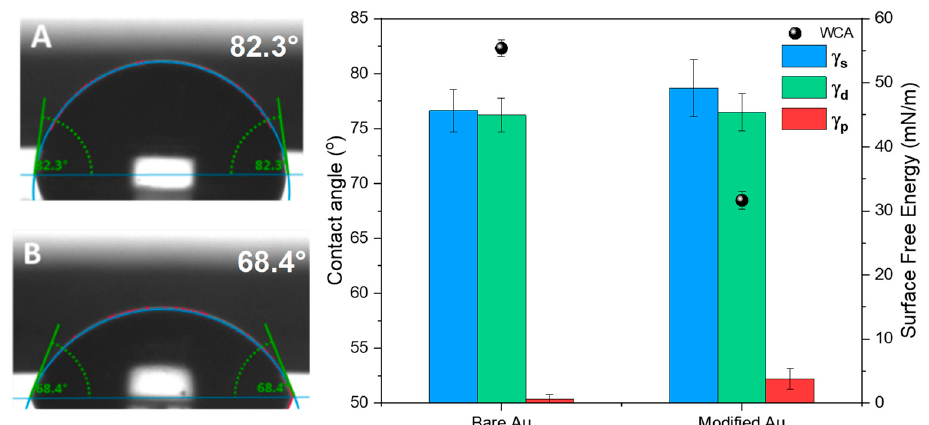
Figure 4. Contact angle and Surface Free Energy diagram for bare ( A ) and peptide modified ( B ) electrode along with contact angle measurement images. γ s —total SFE, γ d —disperse part, γ p —polar part; WCA—water contact angle.